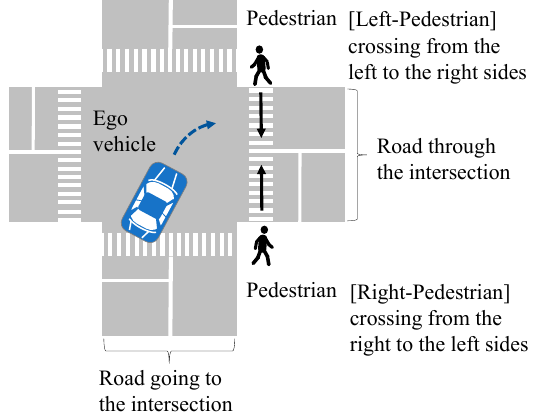
Figure 1. Direction of pedestrian crossing.